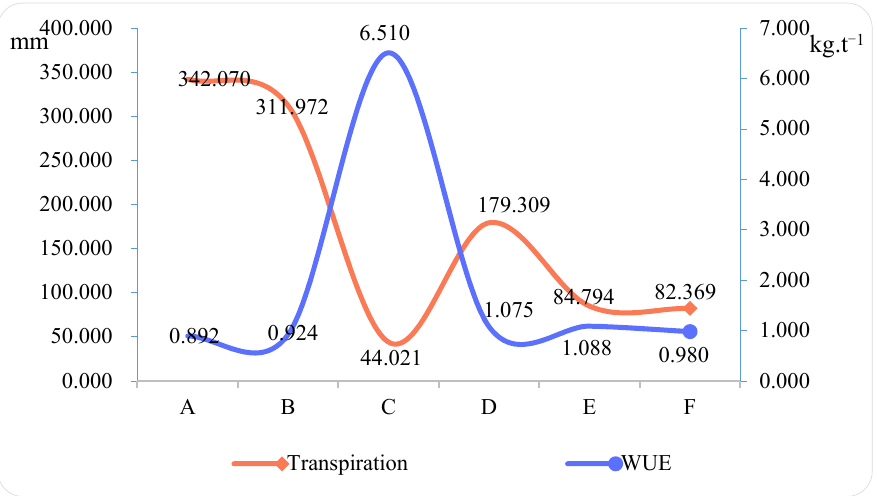
Figure 5. Transpiration and water use efficiency of crops under different planting models.